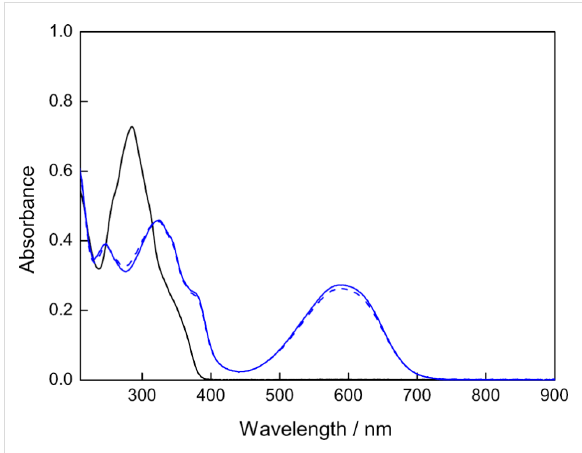
Figure 3: Absorption spectral changes of diarylethene 1o having an ESIPT moiety in THF ( c = 1.3×10 -5 M). Black solid line: 1o , blue solid line: 1c , blue broken line: photostationary state under irradiation with 313 nm light ( 1o / 1c = 4.2: 95.8) (irradiation. for 30 s).